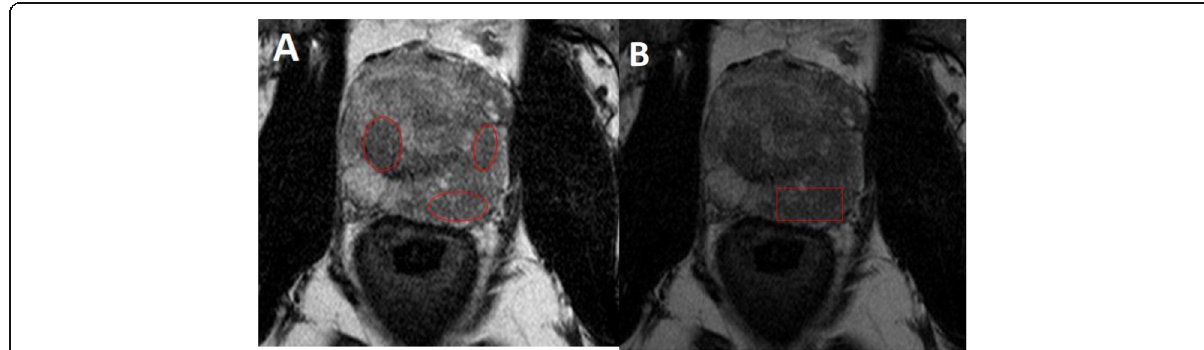
Fig. 3 The partial true prediction from 100-tag iteration: a radiologist identified 3 lesions (red circle) in a testing image. b AI predicted 1 lesion (red rectangle) at the true